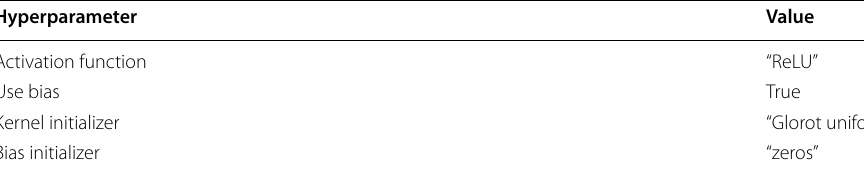
Table 6 Hyperparameters for the Dense layers Hyperparameter